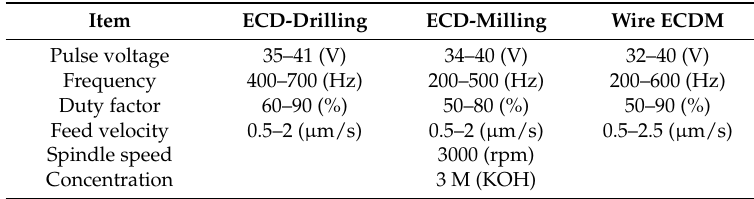
Table 1. The details of experimental